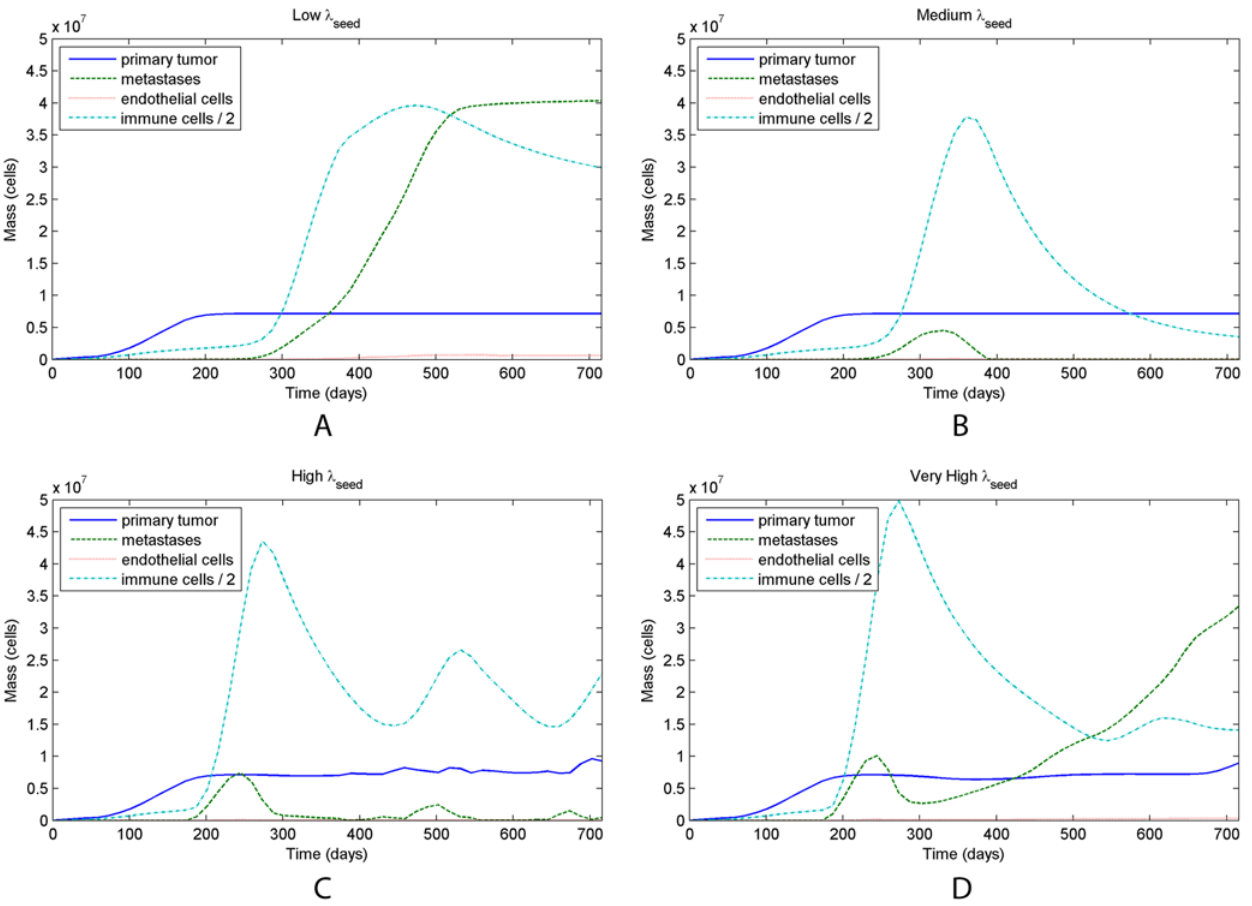
Figure 10. Metastatic growth under different values of l seed . The primary tumor is held to a steady state by the immune response, and metastases are seeded beginning 6 months into the simulation. For the lowest value of l seed , a single metastatic lesion forms; moderate to high values lead to suppression of all metastases, while a very high l seed overwhelms the immune response, leading to widespread metastatic growth. Note that in (C) and (D) the immune response to the metastases can cause perturbations in the primary tumor size, but does not change the overall behavior. (A) l seed ~ 35 : 0 day { 1 . (B) l seed ~ 100 : 0 day { 1 . (C) l seed ~ 2000 : 0 day { 1 . (D) l seed ~ 3000 : 0 day { 1 .